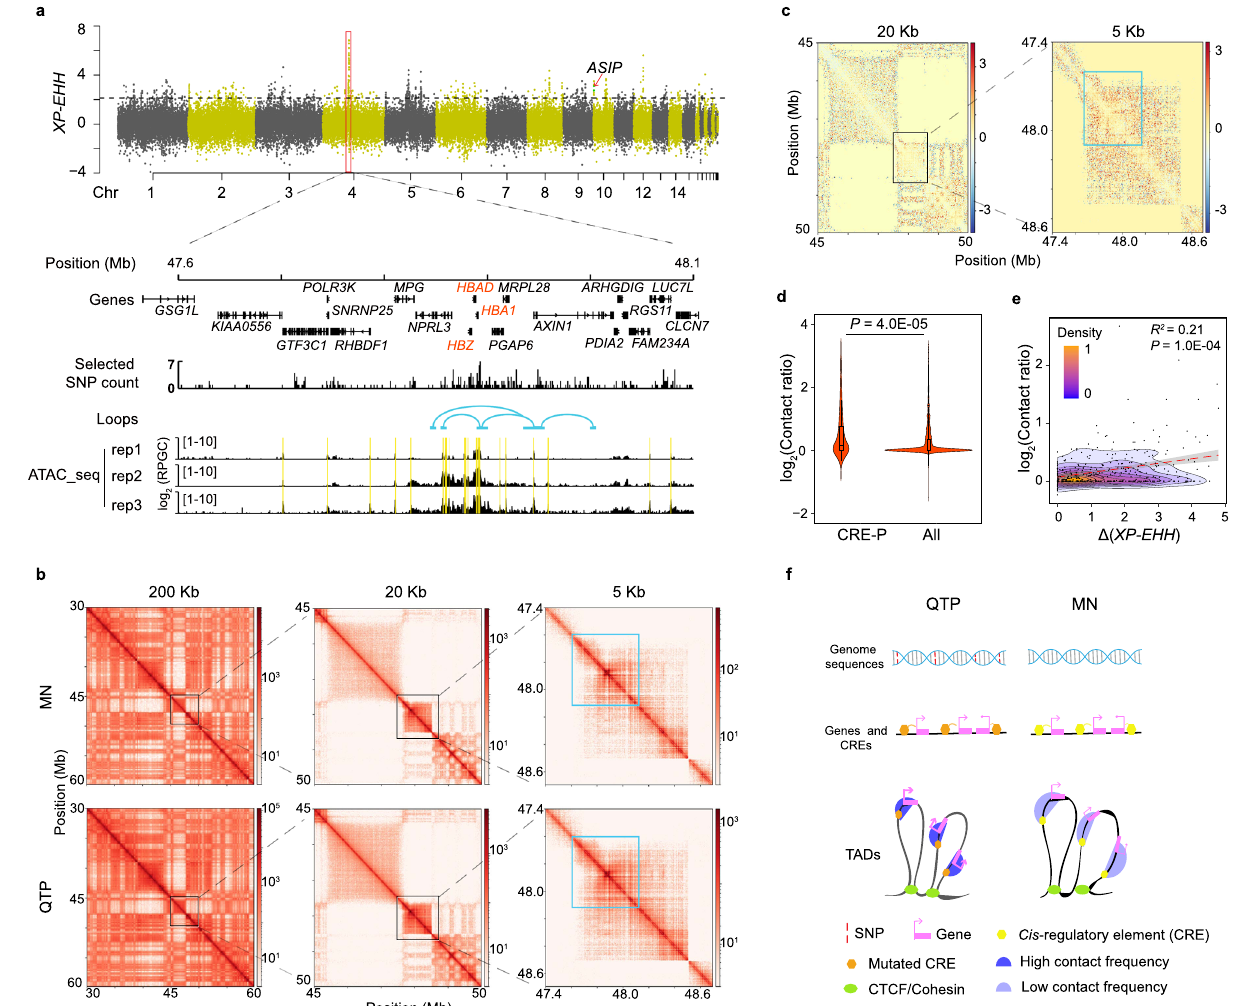
Fig. 4 | Local adaptation and response of QTP sakers to hypoxia. a Positively selectedsignaturesbetweenMNandQTPpopulationsidenti fi edby XP-EHH (top1% value=2.13).Theredboxshowsthefocalhardsweep.Thewindowsizeis1Kb.The ATAC-seq tracks (normalized using reads per genome coverage (RPGC) with log 2 transformed) and Hi-C loops show the cis -regulatory elements (CREs) and 3D structureinthefocalsweepfrombloodsamples.Theyellowblocksshowthepeaks identi fi ed in at least two biological replicates. b Hi-C contact maps at bin sizes of 200Kb,20Kband5Kbinthefocalsweep.Thebluesquareshowsthefocalsweep .c Hi-Ccontactmapsshowingthecontactratio,QTP( N =2)/MNsakers( N =2),inthe sweep at bin sizesof 20Kb and5 Kb,respectively. The blue squareshows the focal sweep. d Comparisonofcontactratio,QTP( N =2)/MNsakers( N =2),betweenthe